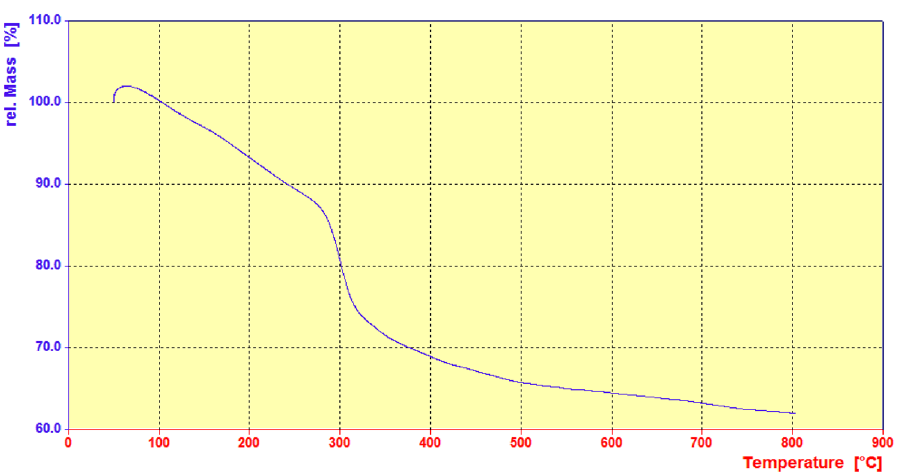
Figure 6 . TGA curve of the LDH–APS–PEI–DTPA nanocomposite ( 1